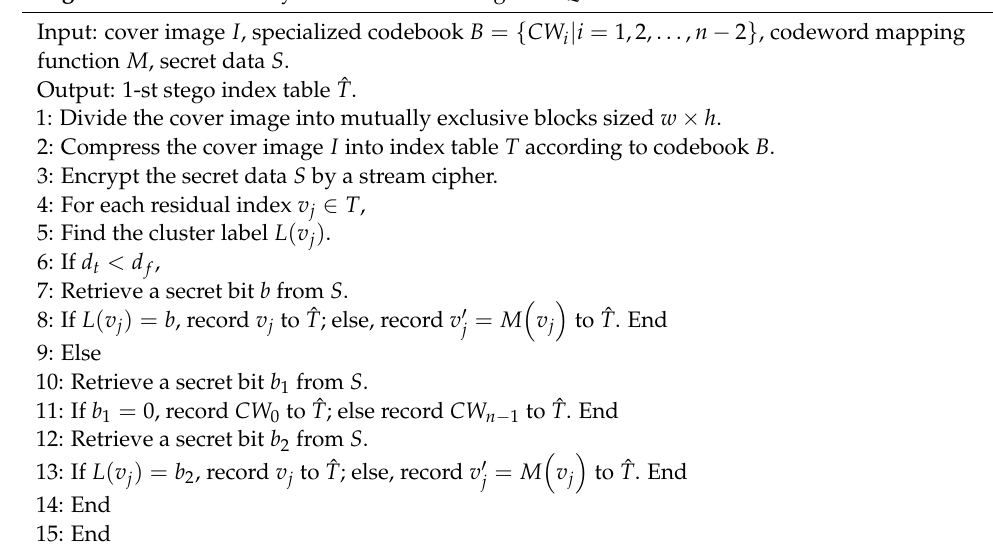
Algorithm 1 . The first-layer of data embedding for VQ index table.